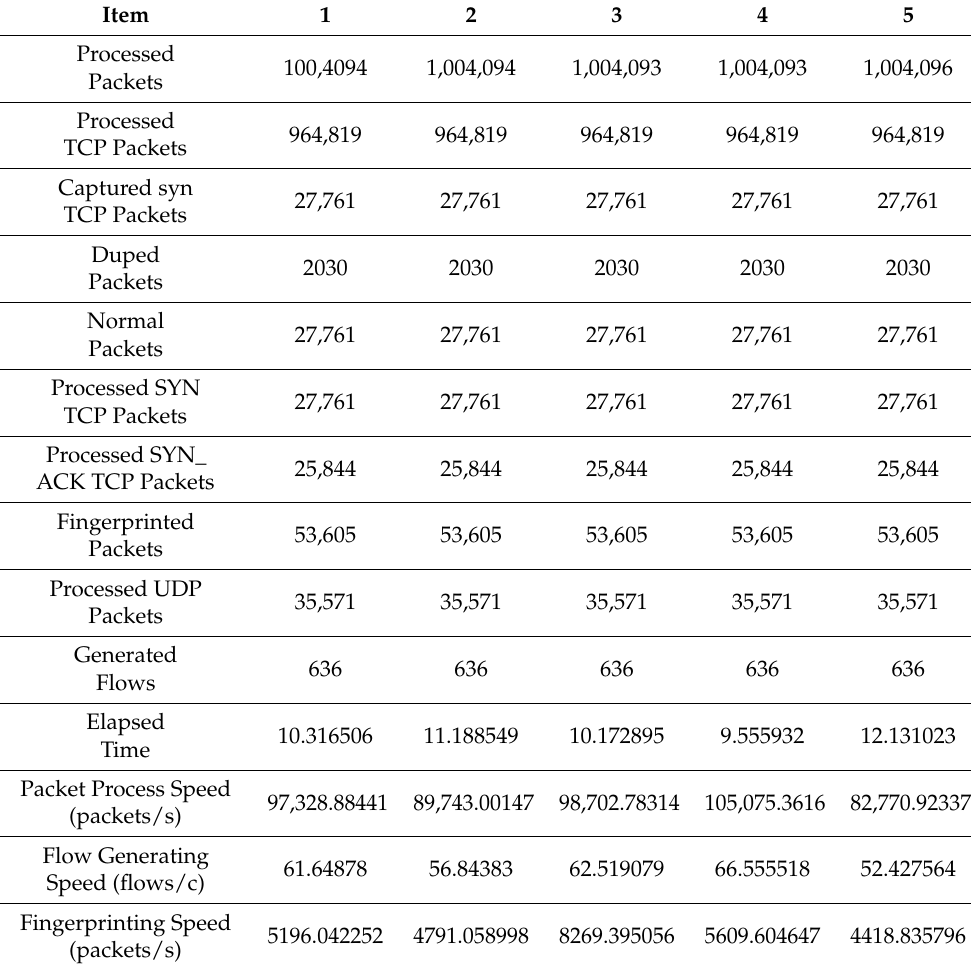
Table 11. Experiment results for the metadata creation success